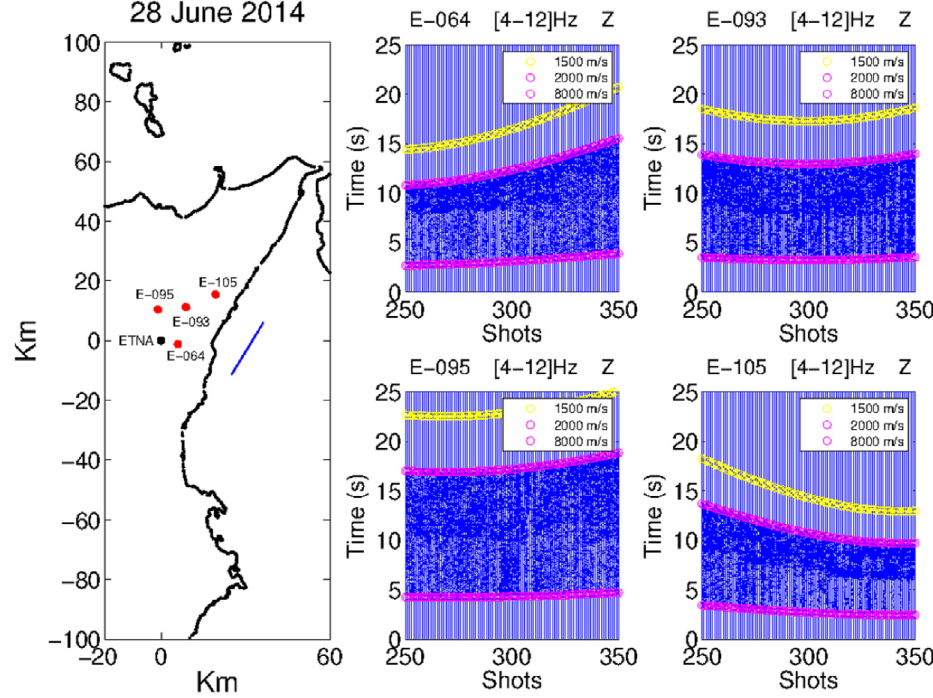
Figure 4. Example of a series of 100 air-gun shots registered in four seismic stations with different distances to the vessel.